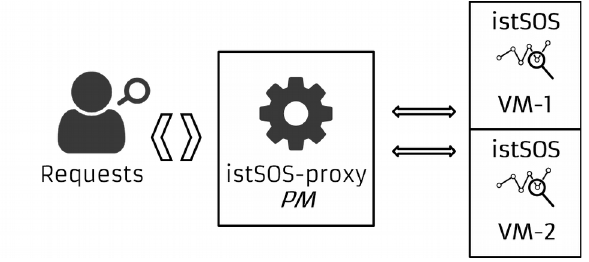
Figure 5. istSOS-proxy